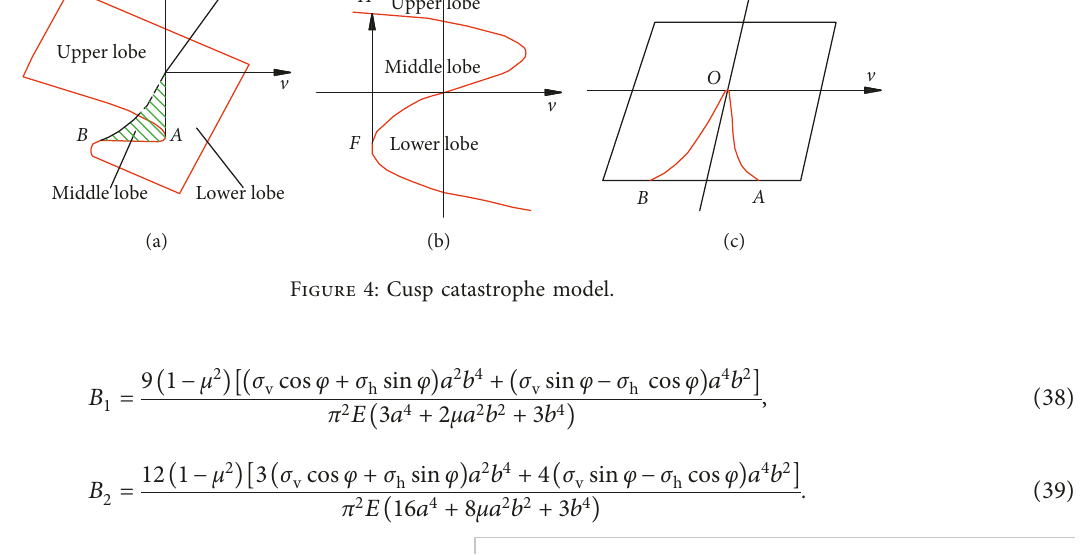
Figure 4: Cusp catastrophe